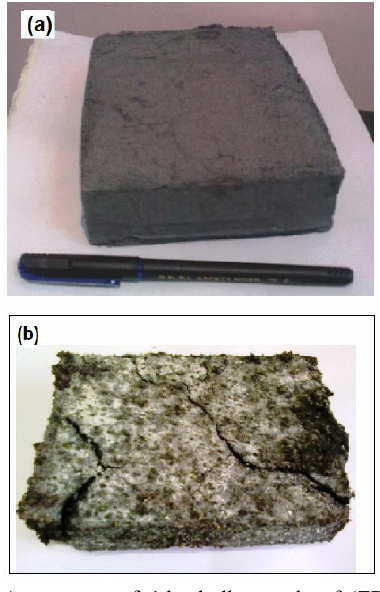
Fig. 9 Appearance of 1 kg bulk sample of (ZRBC2.5+ 15 wt% Si+30 wt% Mg): (a) before and (b) after FT assisted reaction.